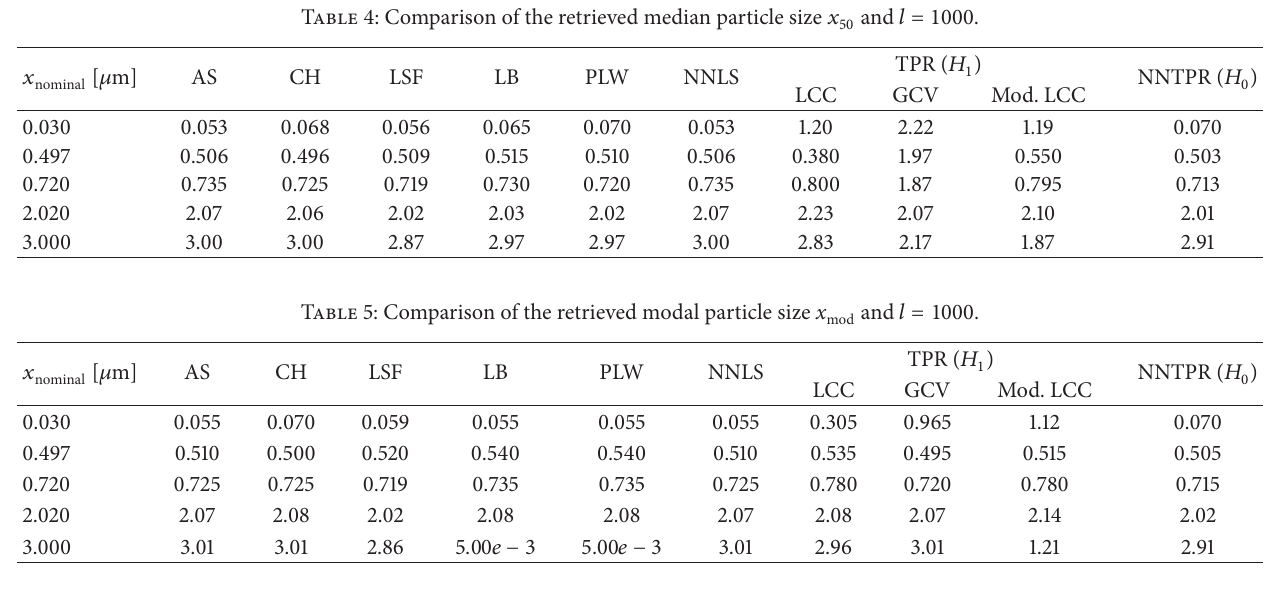
Table 4: Comparison of the retrieved median particle size 𝑥 50 and 𝑙 = 1000 .